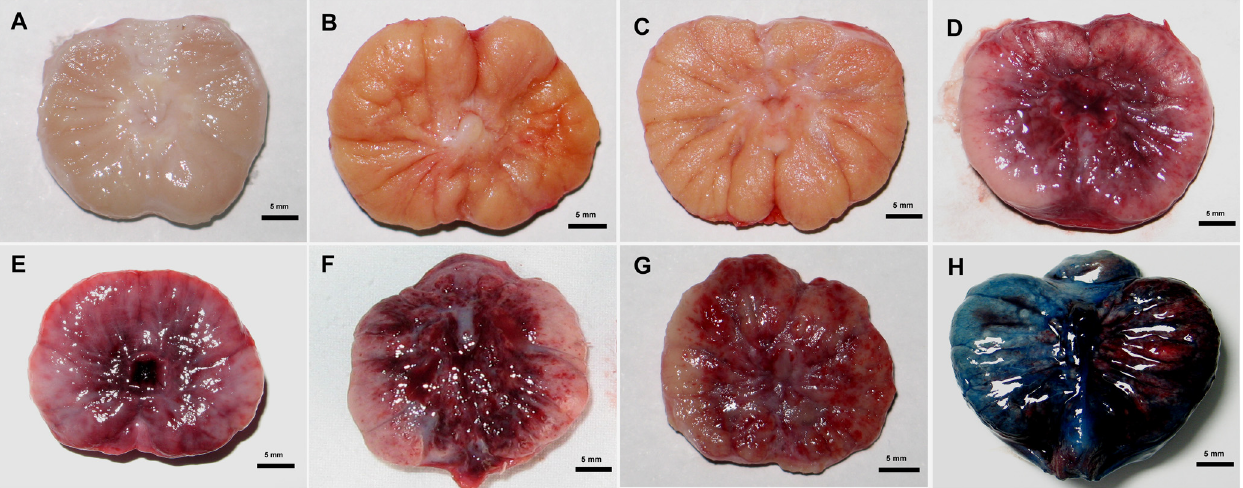
Fig 4. Prostate samples of the different groups obtained after treatment (scale bar = 5 mm). (A-C) Pictures from the prothrombin, microbubbles, and ultrasound-treated specimens (A: Prothrombin group, B: MB group, C: US group) demonstrated normal prostate tissue without hemorrhage. (D, E) The microbubble-enhanced ultrasound (MEUS)-treated prostate showed severe hemorrhage, especially in the tissue surrounding the urethra (D: severe hemorrhage immediately after treatment, E: hemorrhage with irregularly shaped and blurred boundaries 48 hours later). (F, G) The microbubble-enhanced ultrasound and prothrombin (PMEUS)-treated prostate showed more gross severe hemorrhage than the MEUS group throughout most of the gland, and the color was darker (F: severe hemorrhage immediately after treatment, G: diffused hemorrhage with irregular shape 48 hours later). (H) Coronal plains of the prostates with a dividing line of the urinary track demarcating the two parts after Evans blue dyeing. In the presence of microbubbles and prothrombin, the control portion (left) without ultrasound irradiation was homogeneously dyed blue. The ultrasound irradiated part (right) was dark red with severe hemorrhage, indicating that the Evans blue stain was blocked by